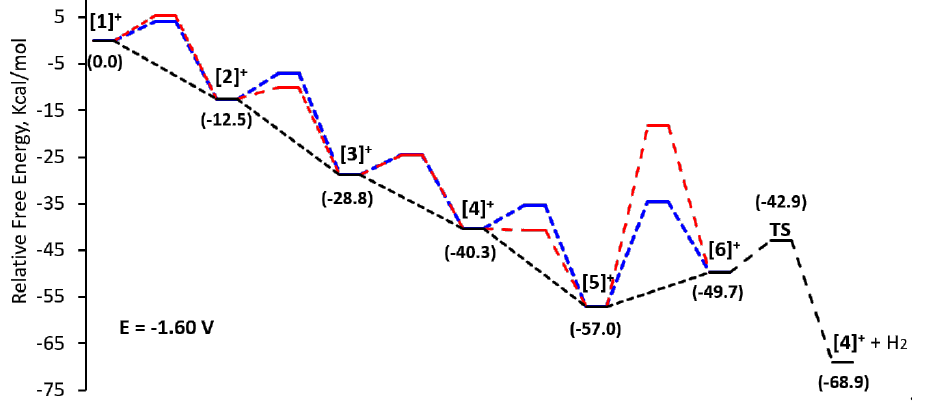
Figure 7. Free energy diagram depicting the possible electron transfer-followed by proton transfer (ET-PT, blue), proton transfer-followed by electron transfer (PT-ET, red) and concerted proton coupled electron transfer (PCET, black) processes of the H 2 evolution catalytic pathway.